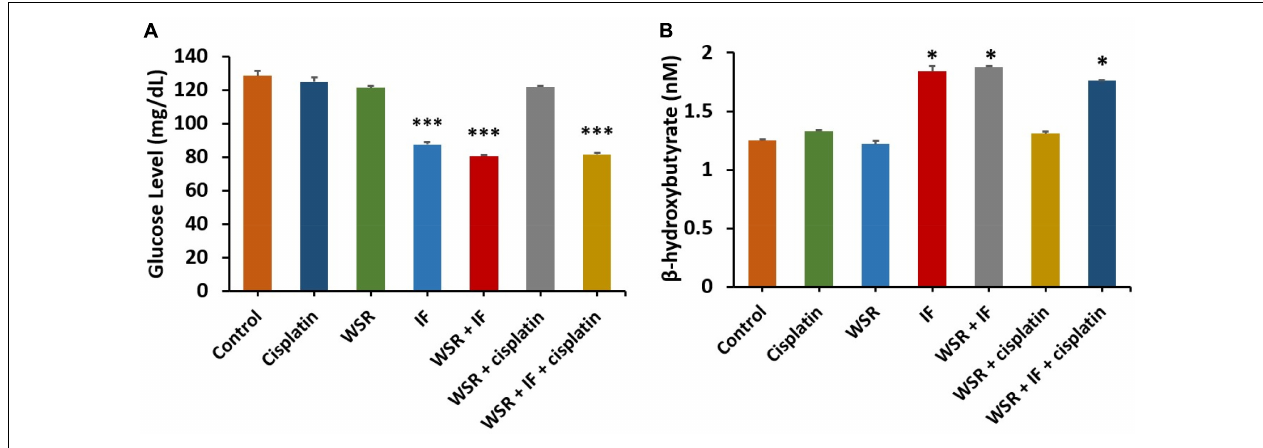
FIGURE 8 | Effect of treatments on glucose and β -hydroxybutyrate (BHB). (A) Serum level of glucose for different treatments. (B) Serum level of BHB for different treatments. Results are expressed as means ± SEM ( n = 3). ∗ P < 0.05, ∗∗∗ P < 0.001. ( ∗ : treatment groups compared with the control group).